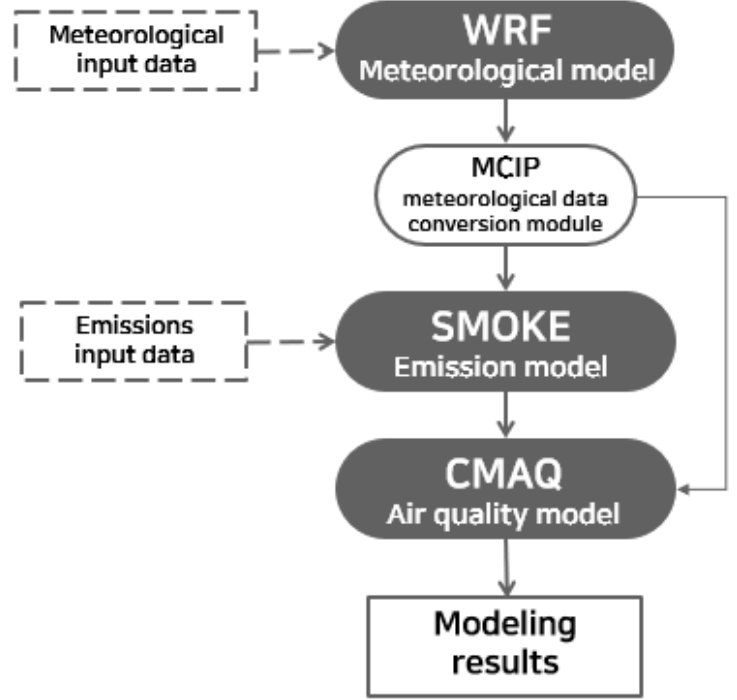
Figure 4. Flowchart of the WRF-SMOKE-CMAQ modeling system.